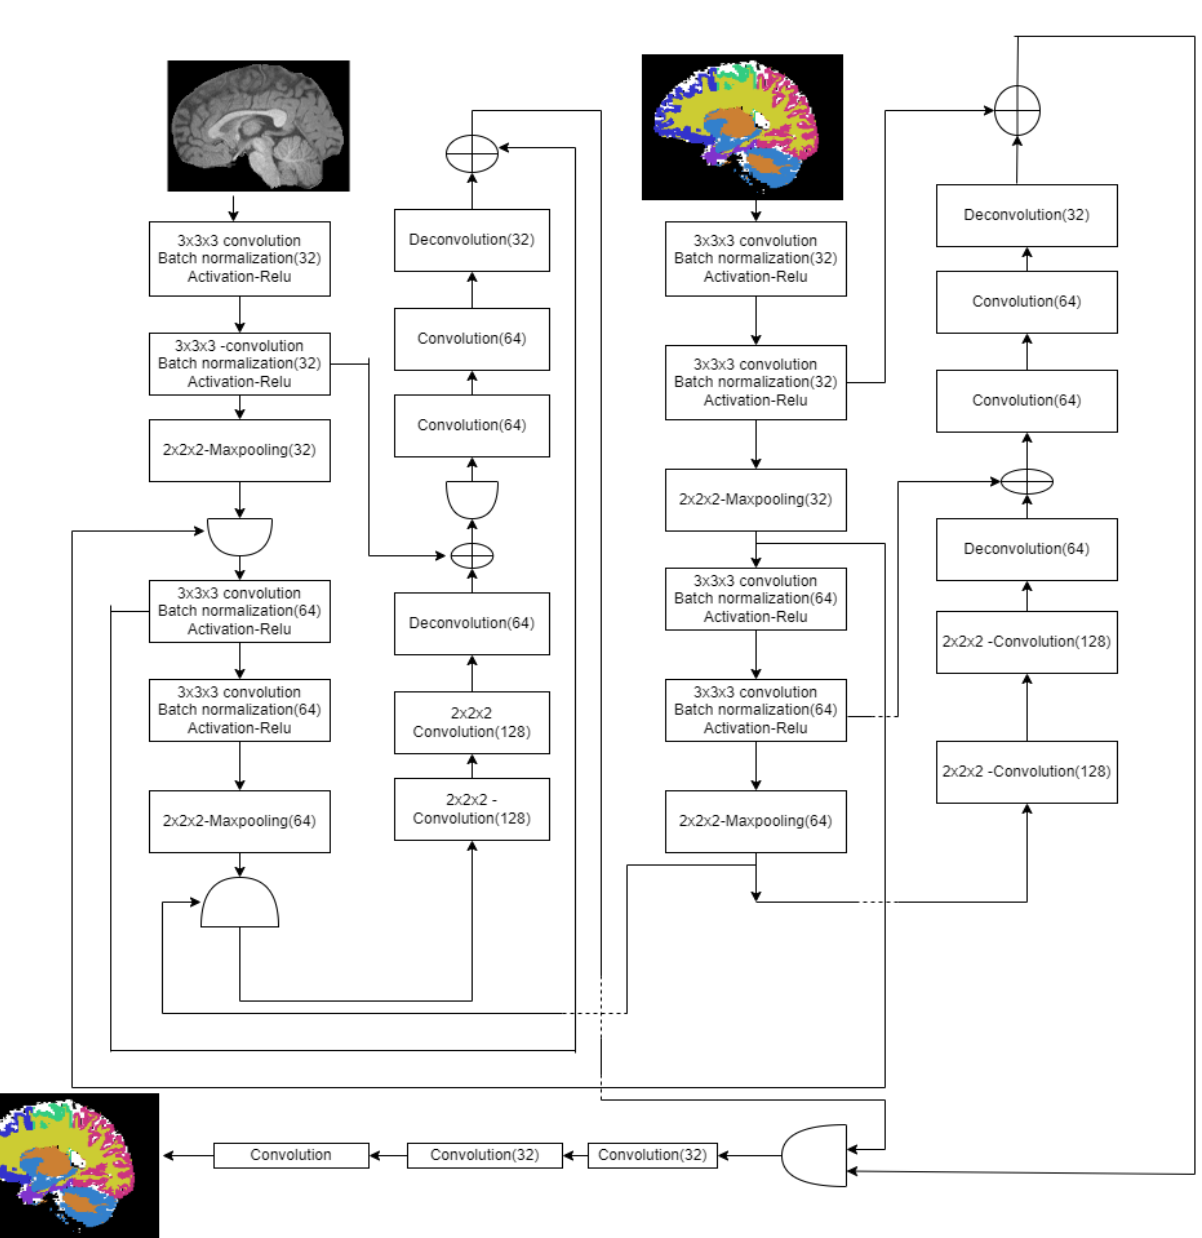
Figure 6. Anatomical attention guided model.